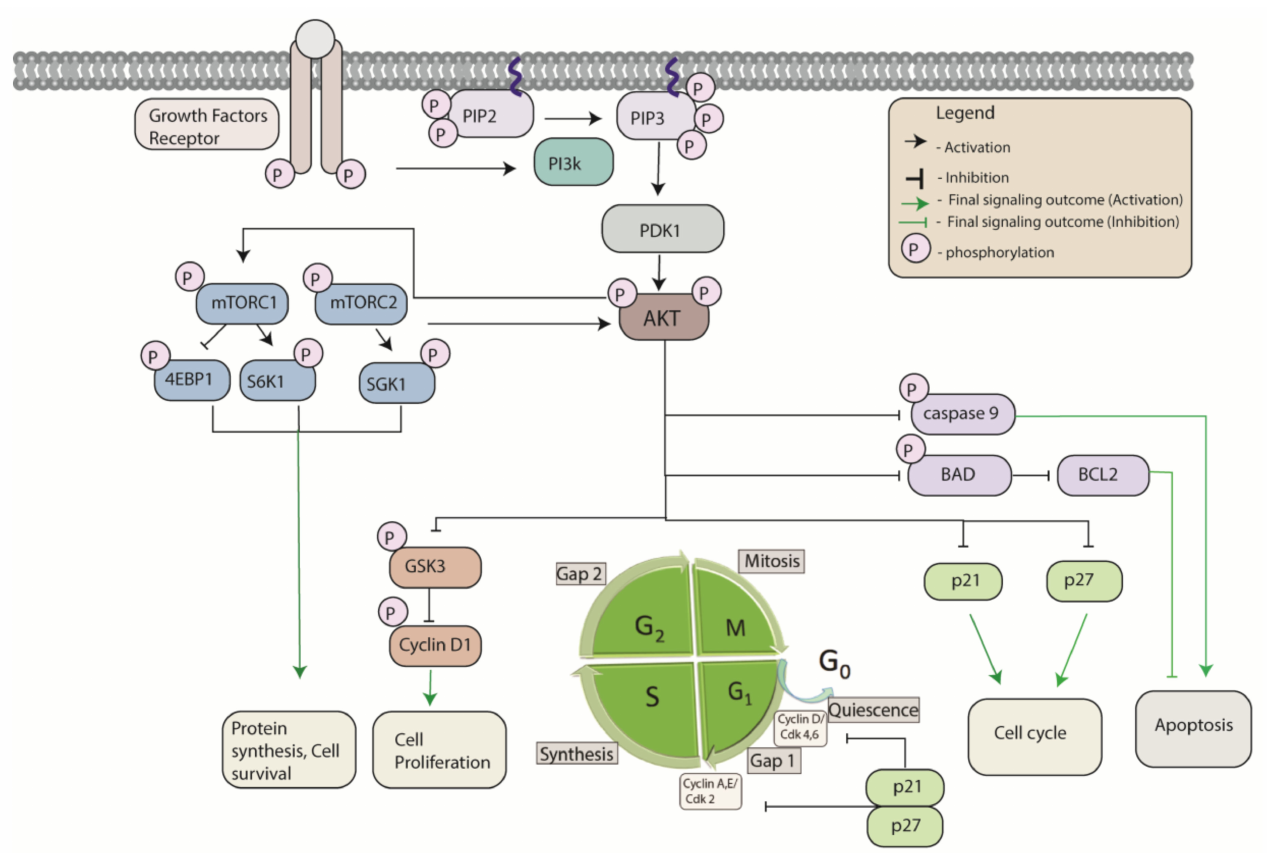
Figure 5. Schematic representation of the phosphatidylinositol 3-kinase (PI3K) signaling pathway and signaling outputs. Conversion of phosphatidylinositol (4,5)-bisphosphate (PIP2) into phosphatidylinositol (3,4,5)-trisphosphate (PIP3), activates phosphatidylinositol-dependent kinase-1 (PDK1) resulting in phosphorylated AKT. Activation of mammalian target of rapamycin complex (mTORC) 1 / 2 results in phosphorylation of eukaryotic translation initiation factor 4e-binding protein1 (4EBP1) / ribosomal protein S6 kinase 1 (S6K1) / serum and glucocorticoid-induced protein kinase (SGK). Glycogen synthase kinase 3 (GSK3) inhibits S phase specific cyclin D1 levels, regulating cell proliferation. AKT inhibits cyclin-dependent kinase (CDK) inhibitors, p21 and p27 promoting cell cycle progression. AKT inhibits the activation of caspase 9 and BCL-2 associated agonist of cell death (BAD), resulting in the inhibition of